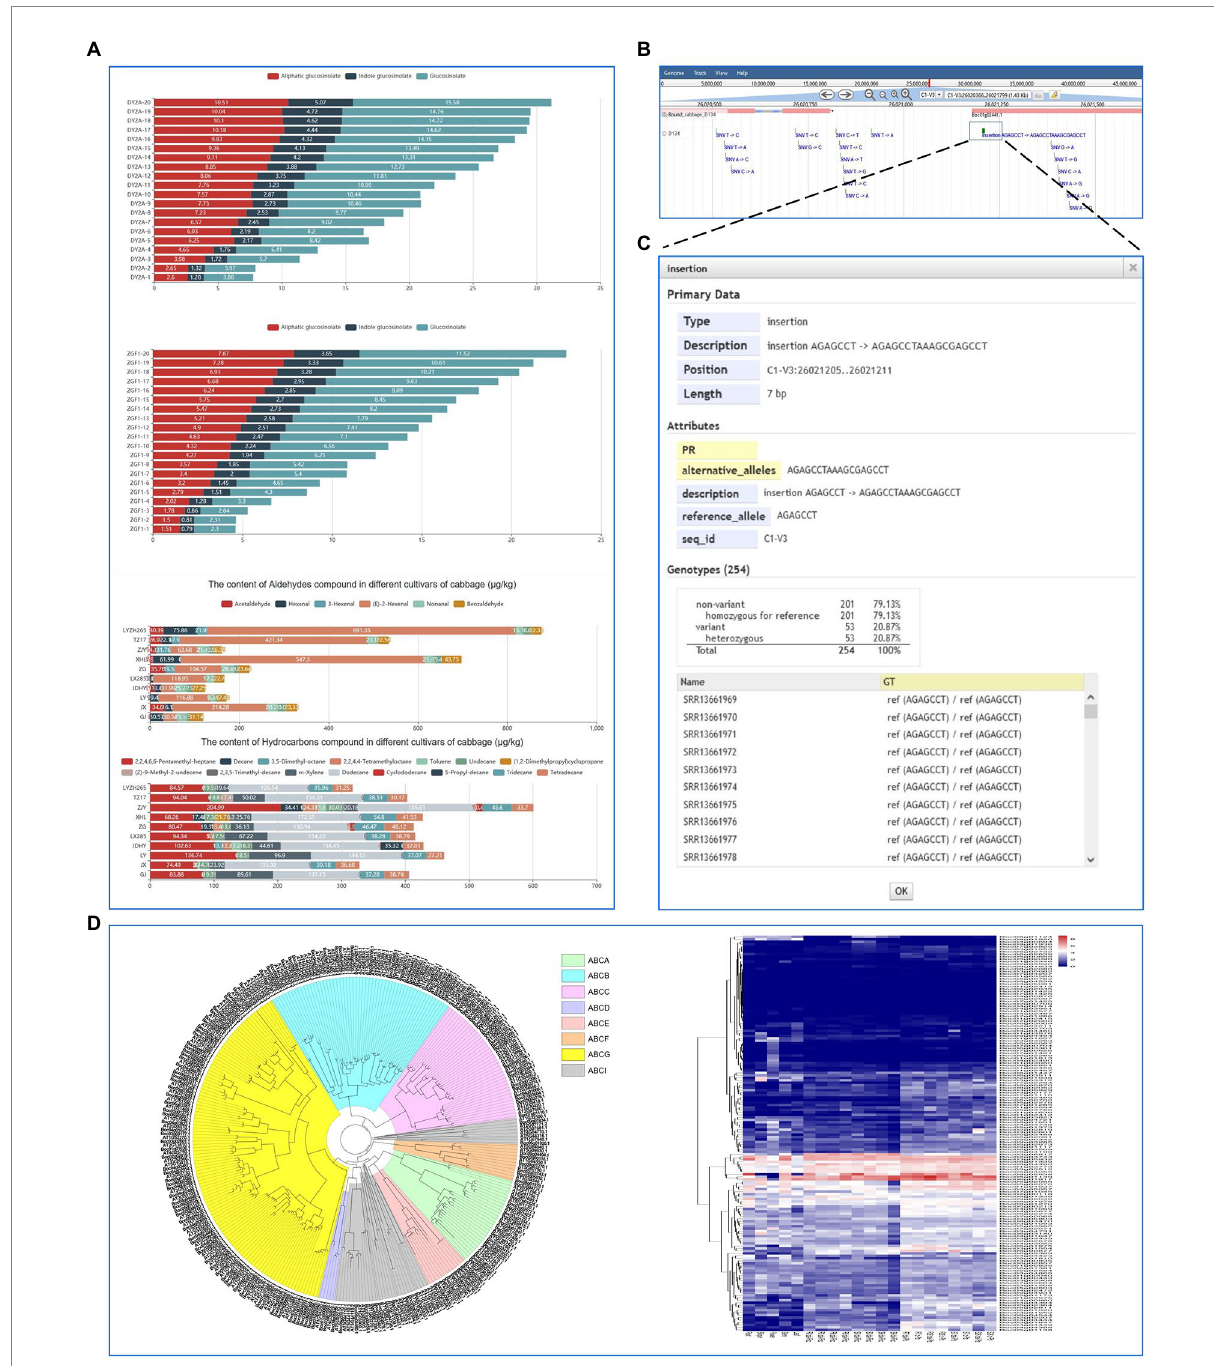
FIGURE 5 “ Metabolic” and “Variation” modules and a case study for the application of BoGDB. (A) The “Metabolic” module presents the information of primary and secondary metabolites and volatile components. (B) The “Variation” module displays the genetic loci of SNPs and InDels across the 254 B. oleracea accessions. (C) Detailed information of variation sites. (D) A case study for the application of